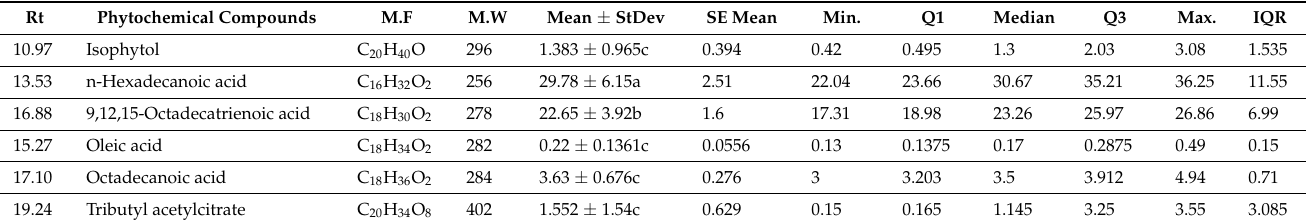
Table 7. Major phytochemical compounds identified in hexane extract of Ricinus communis . RT: Retention time (in minutes); MF: molecular formula; MW: molecular weight. Different letters represent significant differences.